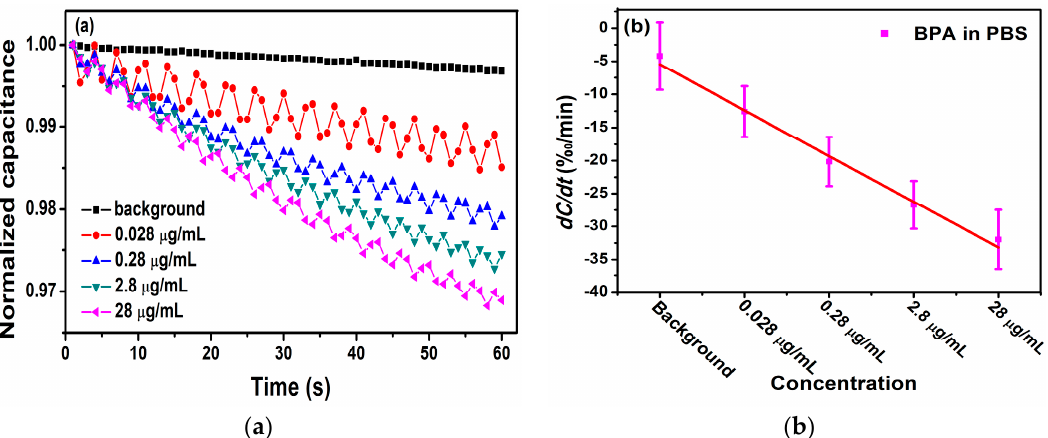
Figure 7. ( a ) Detection of different concentrations of antigen with 5.3 μ g/mL of antibody. ( b ) The change rate of capacitance as a function of BPA concentrations in 0.01 × PBS.